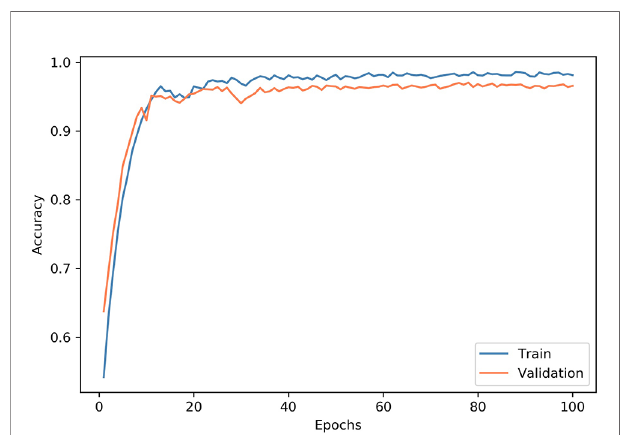
FIGURE 5 | Convergence of the network training. At each epoch, the model was trained using all images in the training dataset, and the accuracy was evaluated. At the end of each epoch, we measured the accuracy of the model on the validation dataset. After 100 epochs, the training was stopped since both accuracy and cross-entropy loss would not be further improved.